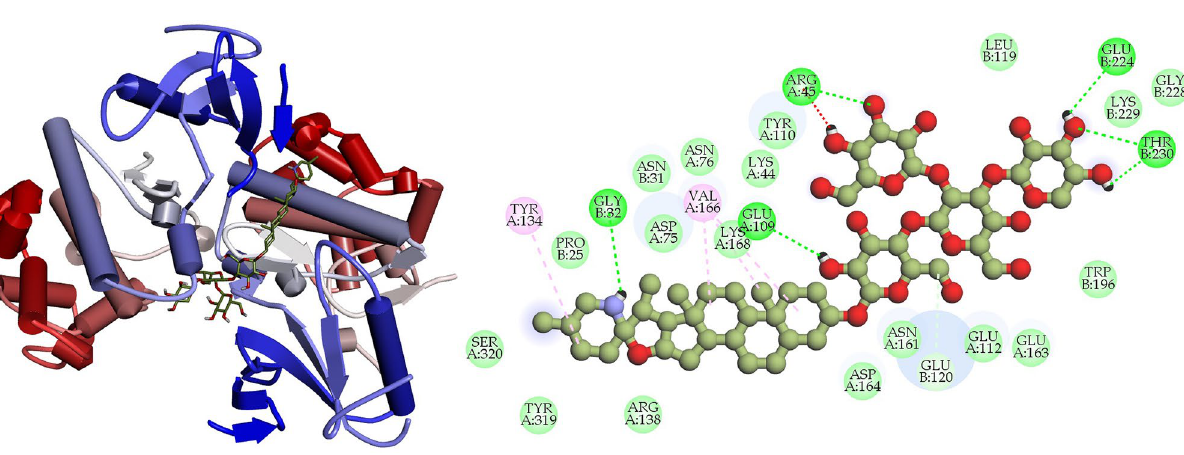
Figure 6. Depicted the interaction between the compound CID: 5280805 (Rutin) and MAPK6. Left side representing 3D and the right side representing 2D complex protein–ligand interaction.